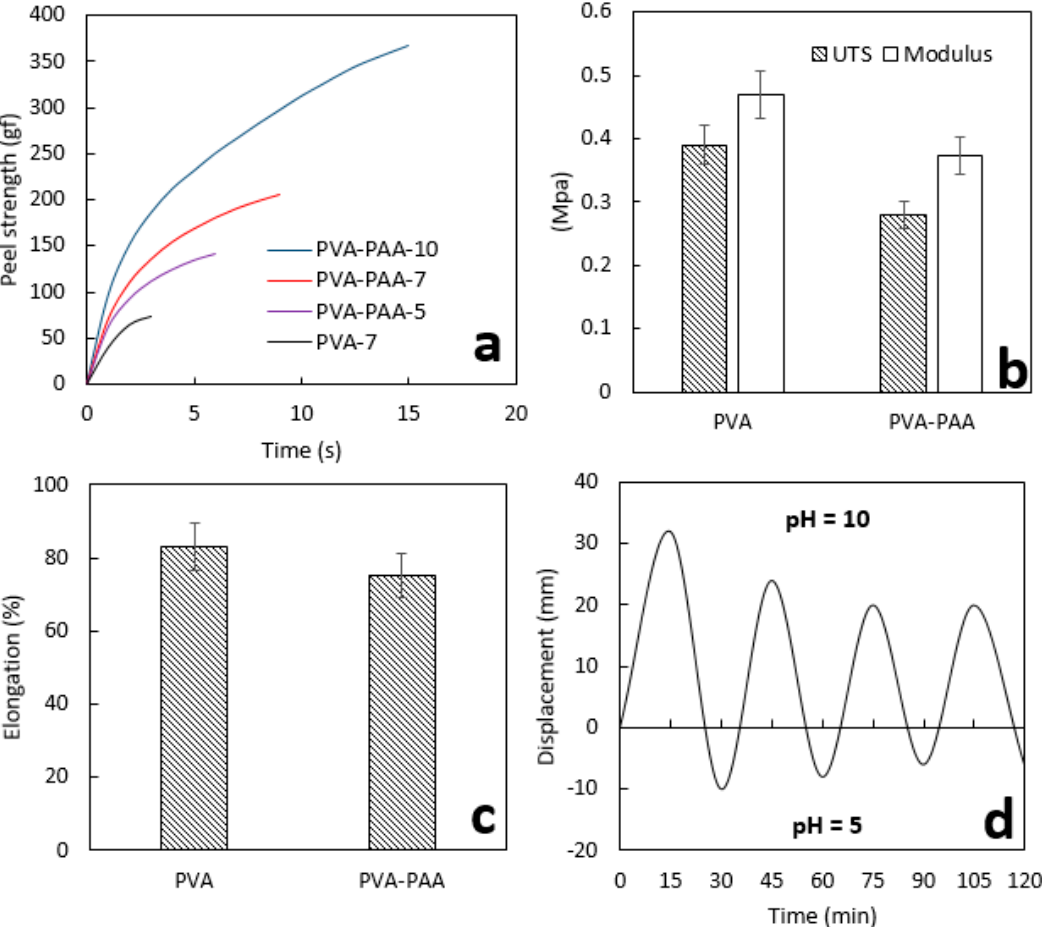
Figure 6. ( a ) Adhesion and ( b , c ) mechanical properties of PVA and PVA-PAA hydrogels and ( d ) pH sensitivity results of PVA-PAA samples (the PAA side was upward) at different pH values of 5 and 10. UTS: ultimate tensile strength.